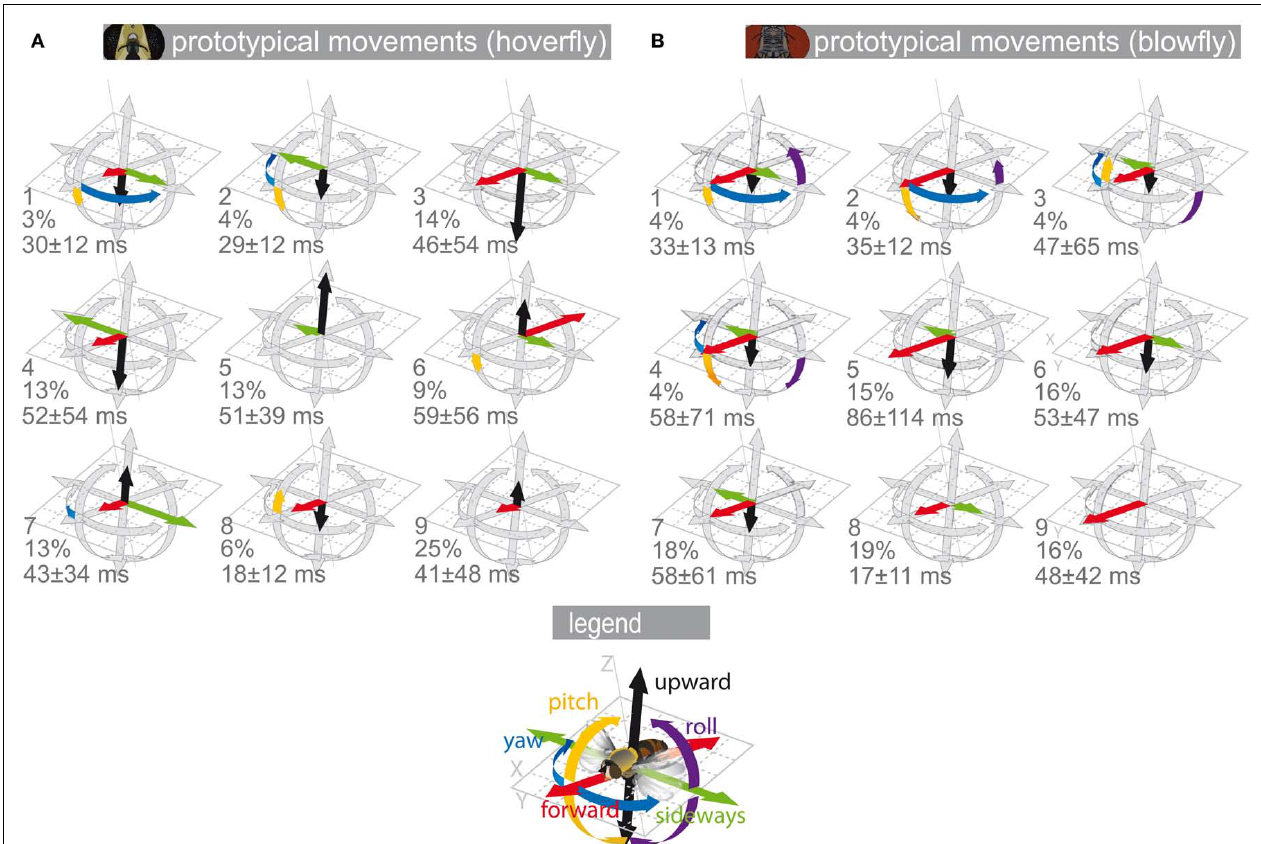
The colored arrows show the velocity combination for that PM (for color code see inset).The PMs are numbered. Below the PM number are its percentage in the data and its mean duration ± SD. (A) Eristalis PMs derived from body trajectories omitting roll velocities, which we could not track for a larger dataset (see Materials and Methods). (B) Calliphora PMs derived from head trajectories (Braun et al., 2010).